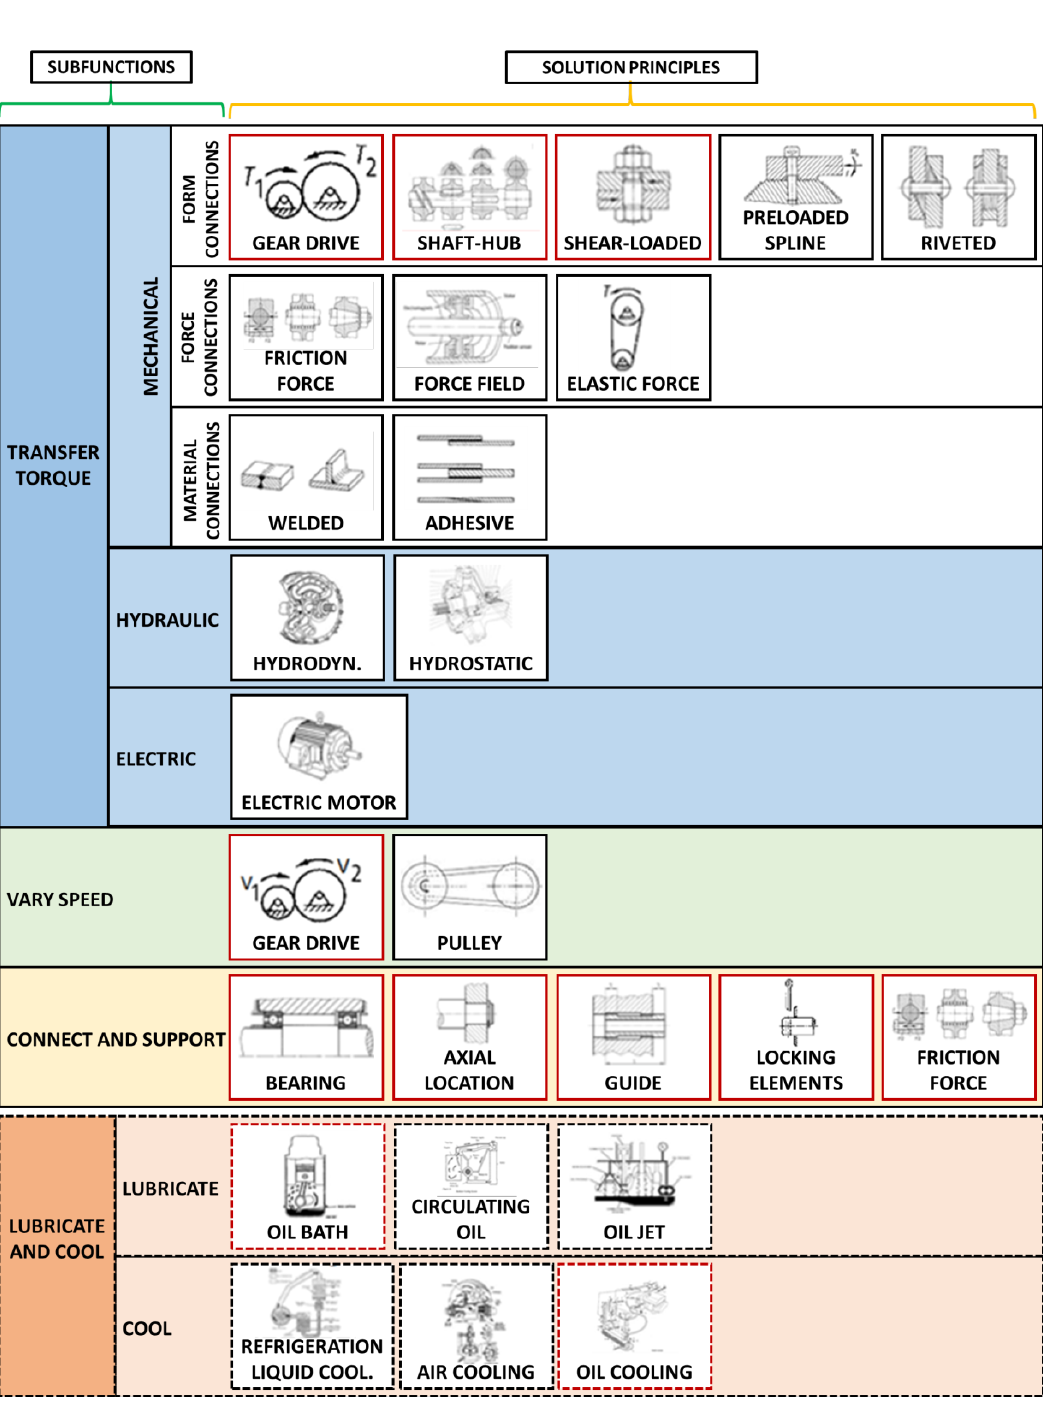
Figure 10. Classification of subfunctions and possible solution principles.